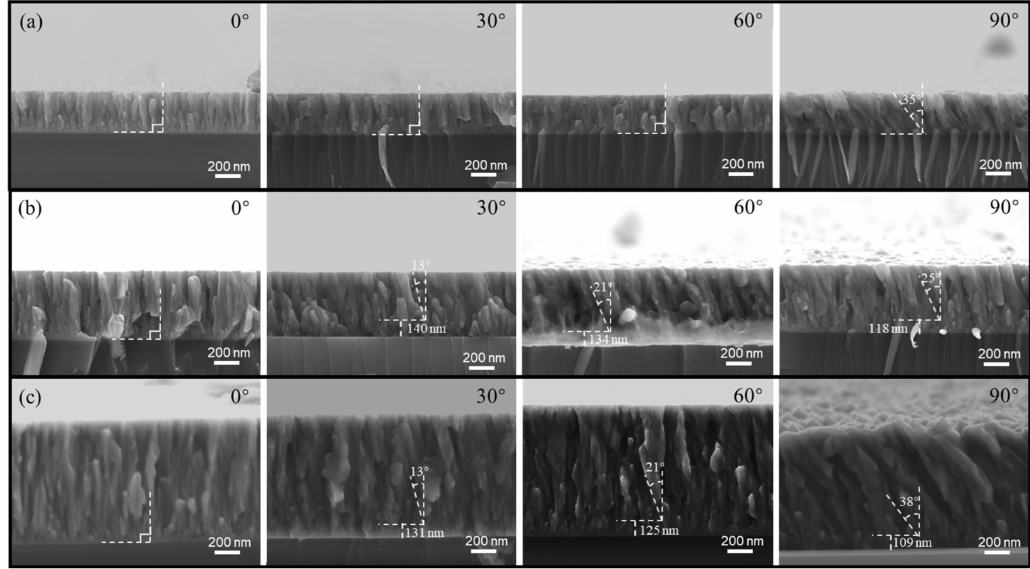
Figure 3. Cross-sectional morphology of Ti films deposited on SiO 2 substrates with film thicknesses of 300 nm ( a ), 500 nm ( b ), and 1000 nm ( c